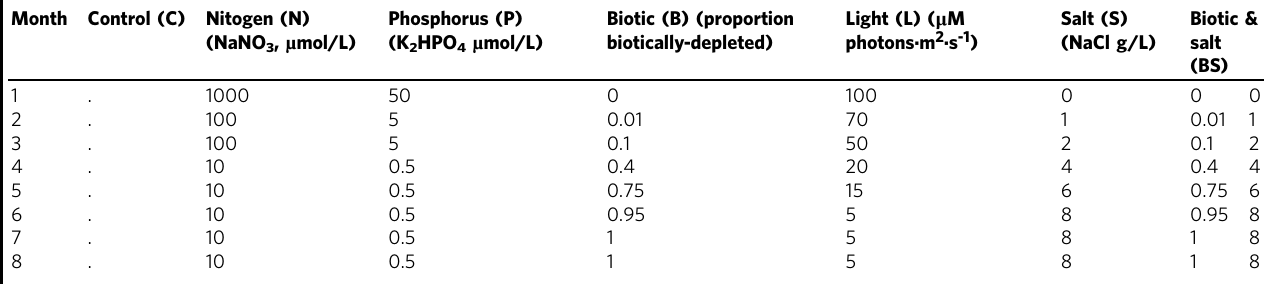
Table 1 The temporal sequence of resource-limitation and salt stress experimental treatments Month Control (C) Nitogen (N)